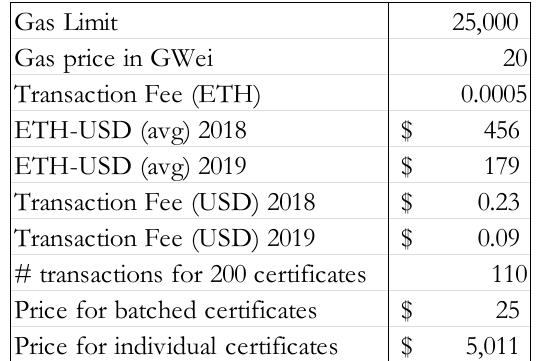
Table 2: Cost of using the Ethereum network for registering 22,000 academic certificates per